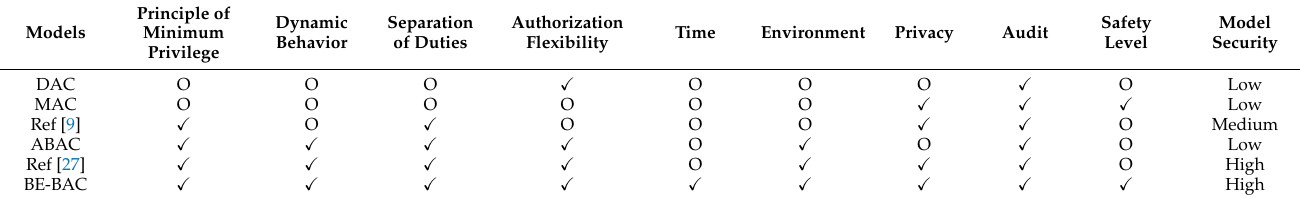
Table 3. Comprehensive analysis and comparison of access-control